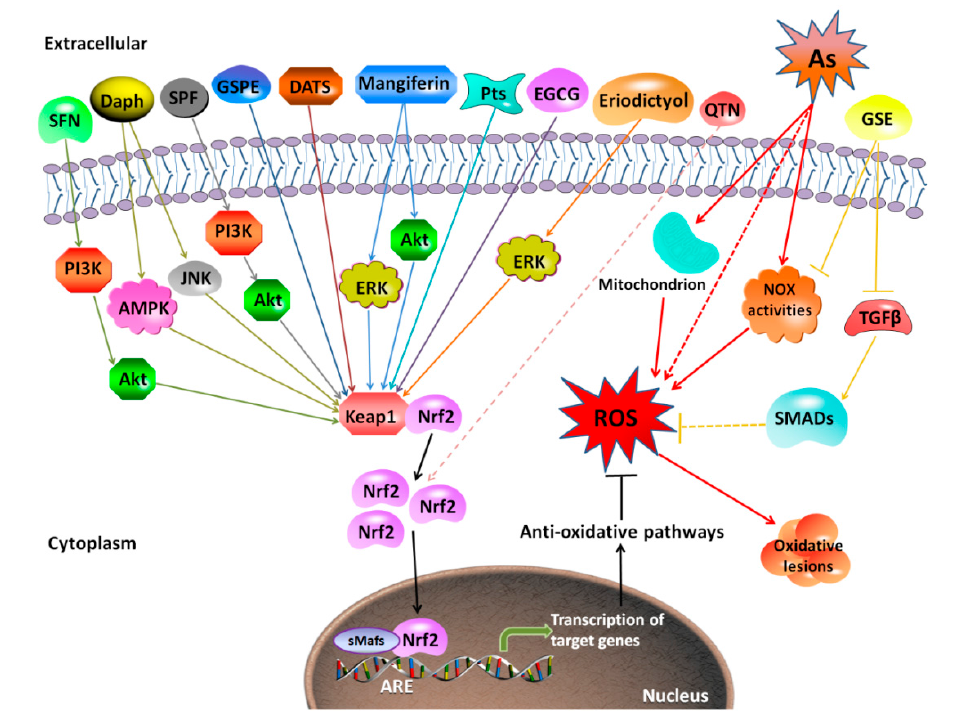
Figure 3. Mechanism of protective effects against arsenic-induced toxicity by antioxidants extracted from plants. The representative natural antioxidants extracted from plants show various mechanisms for protection against arsenic-induced toxicity. Most of them (SFN, Daph, SPF, GSPE, DATS, mangiferin, Pts, EGCG, and eriodictyol) promote the dissociation of Nrf2 with Keap1, promoting the expression of downstream genes of Nrf2, and finally increasing the antioxidant capacity. QTN is suggested to act though Nrf2 without clear evidence. Additionally, GSE protects against arsenic-induced oxidative damage through suppression of NOX-mediated ROS generation. SFN, sulforaphane; Daph, daphnetin; SPF, Sorbus pohuashanensis flavonoids; GSPE, grape seed proanthocyanidin extract; DATS, diallyl trisulfide; Pts, pterostilbene; EGCG, (-)-Epigallocatechin-3-gallate; GSE, grape seed extract; TGF β , transforming growth factor- β ; NOX, Nicotinamide adenine dinucleotide phosphate oxidase; SMADs, drosophila mothers against decapentaplegic protein.